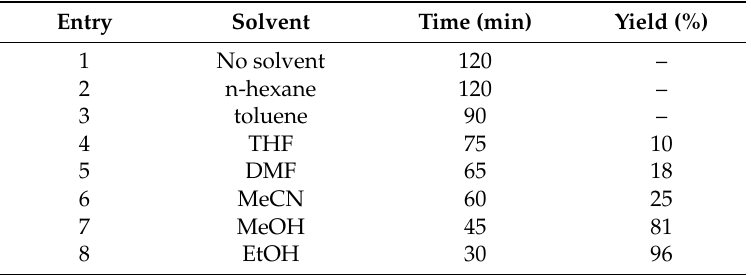
Table 2. Optimization of various solvent conditions for the model reaction a